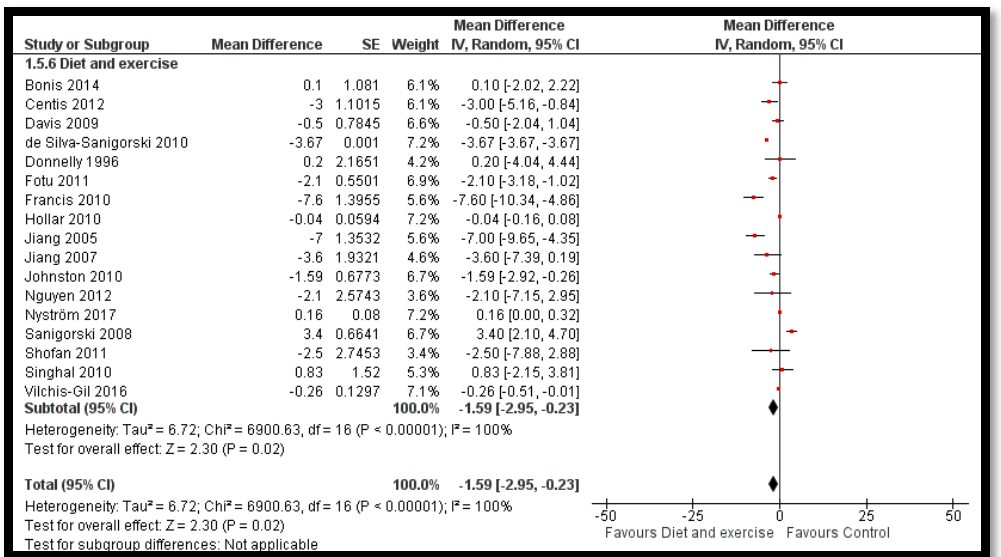
Figure 5. Forest plot for the effect combined diet and exercise interventions for obesity prevention on body weight.